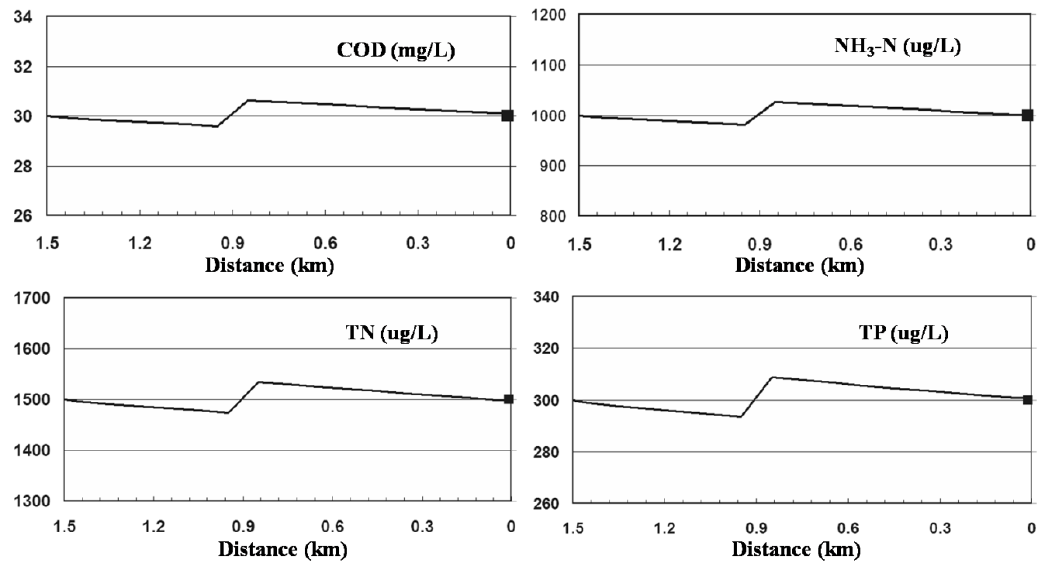
Figure 7. Simulation curve of water environmental